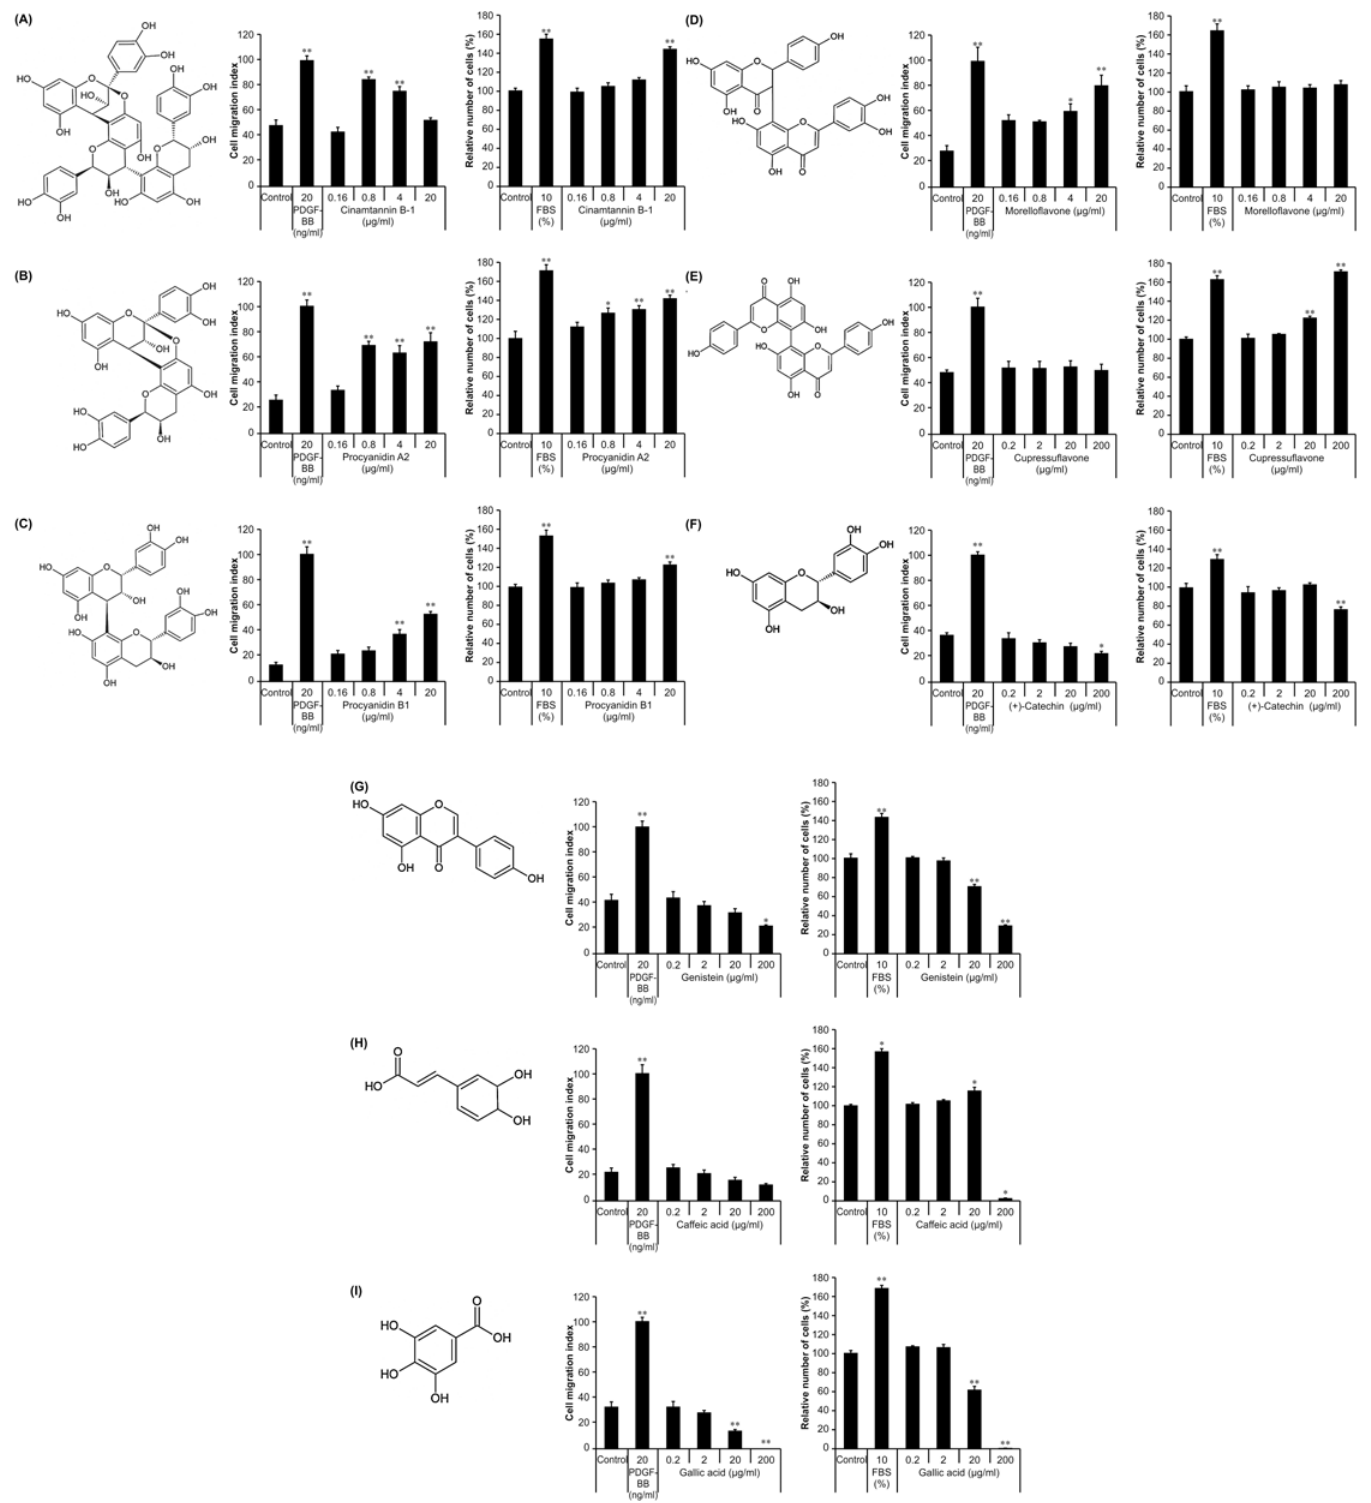
Fig 4. Effects of various flavonoids and polyphenols on KUM6 cells. (A) Structure of cinnamtannin B-1 and MSC migration and proliferation after stimulation with cinnamtannin B-1, (B) procyanidin A2, (C) procyanidin B1, (D) morelloflavone, (E) cupressuflavone, (F) (+)-catechin, (G) genistein,